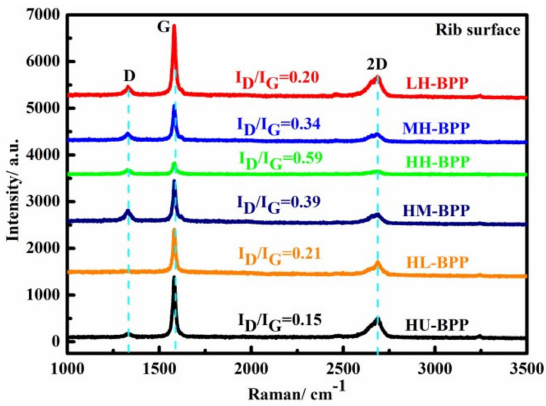
Figure 4. Raman spectra of composite BPs under different combination of molding and impregnation